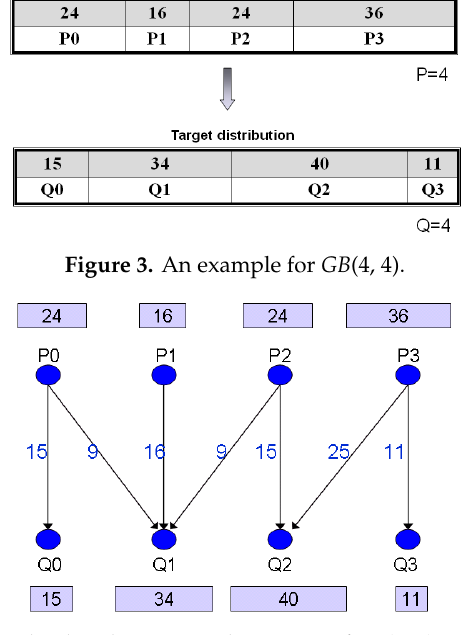
Figure 4. The distribution graph G GB (4, 4) of GB (4, 4) in Figure 3.